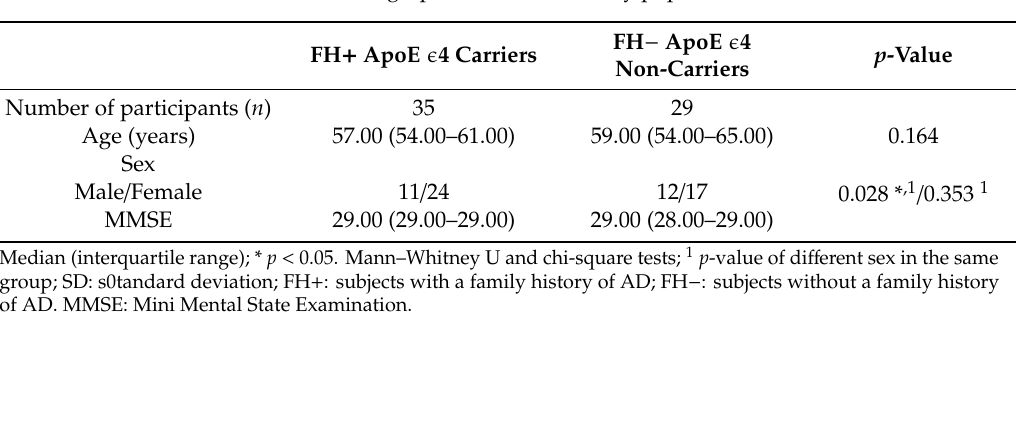
Table 3. Demographic data of the study population.